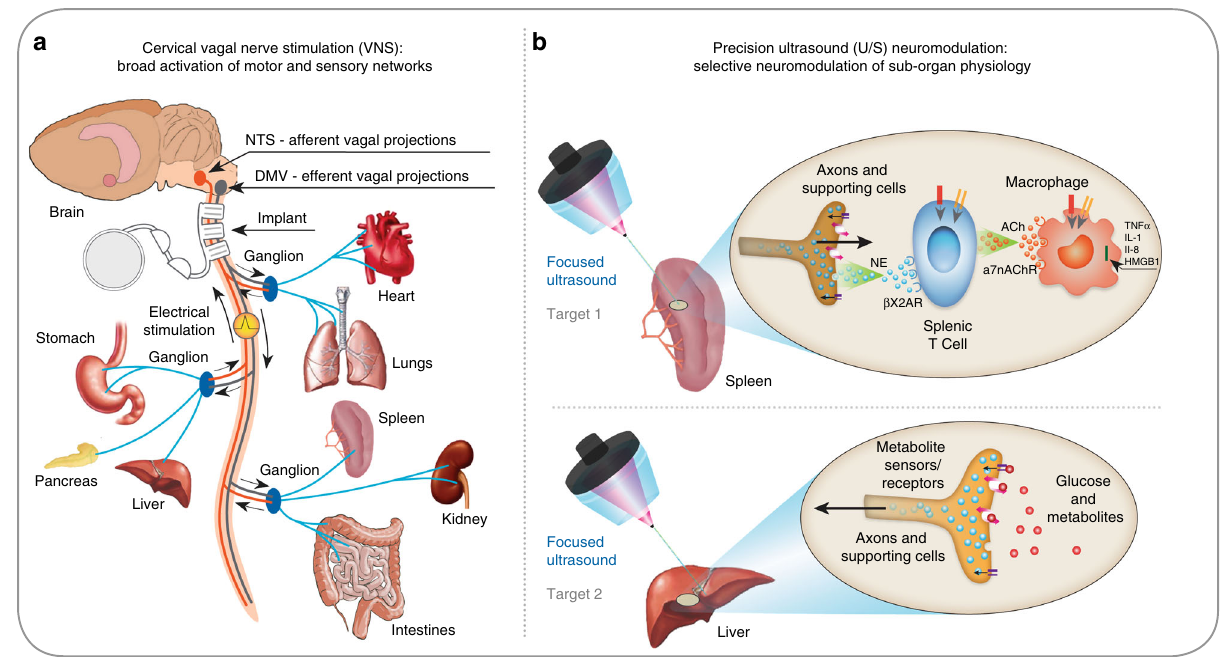
Fig. 1 Implant-based vagus nerve stimulation (VNS) versus precision ultrasound (U/S) neuromodulation. a A schematic of the neurons within the vagus nerve, exemplary innervated organs, and the common cervical position used for VNS devices. Stimulation of the cervical vagus results in stimulation of both target and non-target efferent and afferent pathways 1 – 10 . Clinical implementation of miniature stimulators and advanced electrode designs that can be implanted closer to the target organ (for precision stimulation of axons entering only that organ) is challenging and remains elusive 9,17,18 . b A schematic of precision organ-based neuromodulation in which the innervation points of known axonal populations are targeted for stimulation using focused pulsed U/S. Targets investigated herein include innervation points within the spleen and sensory terminals within the